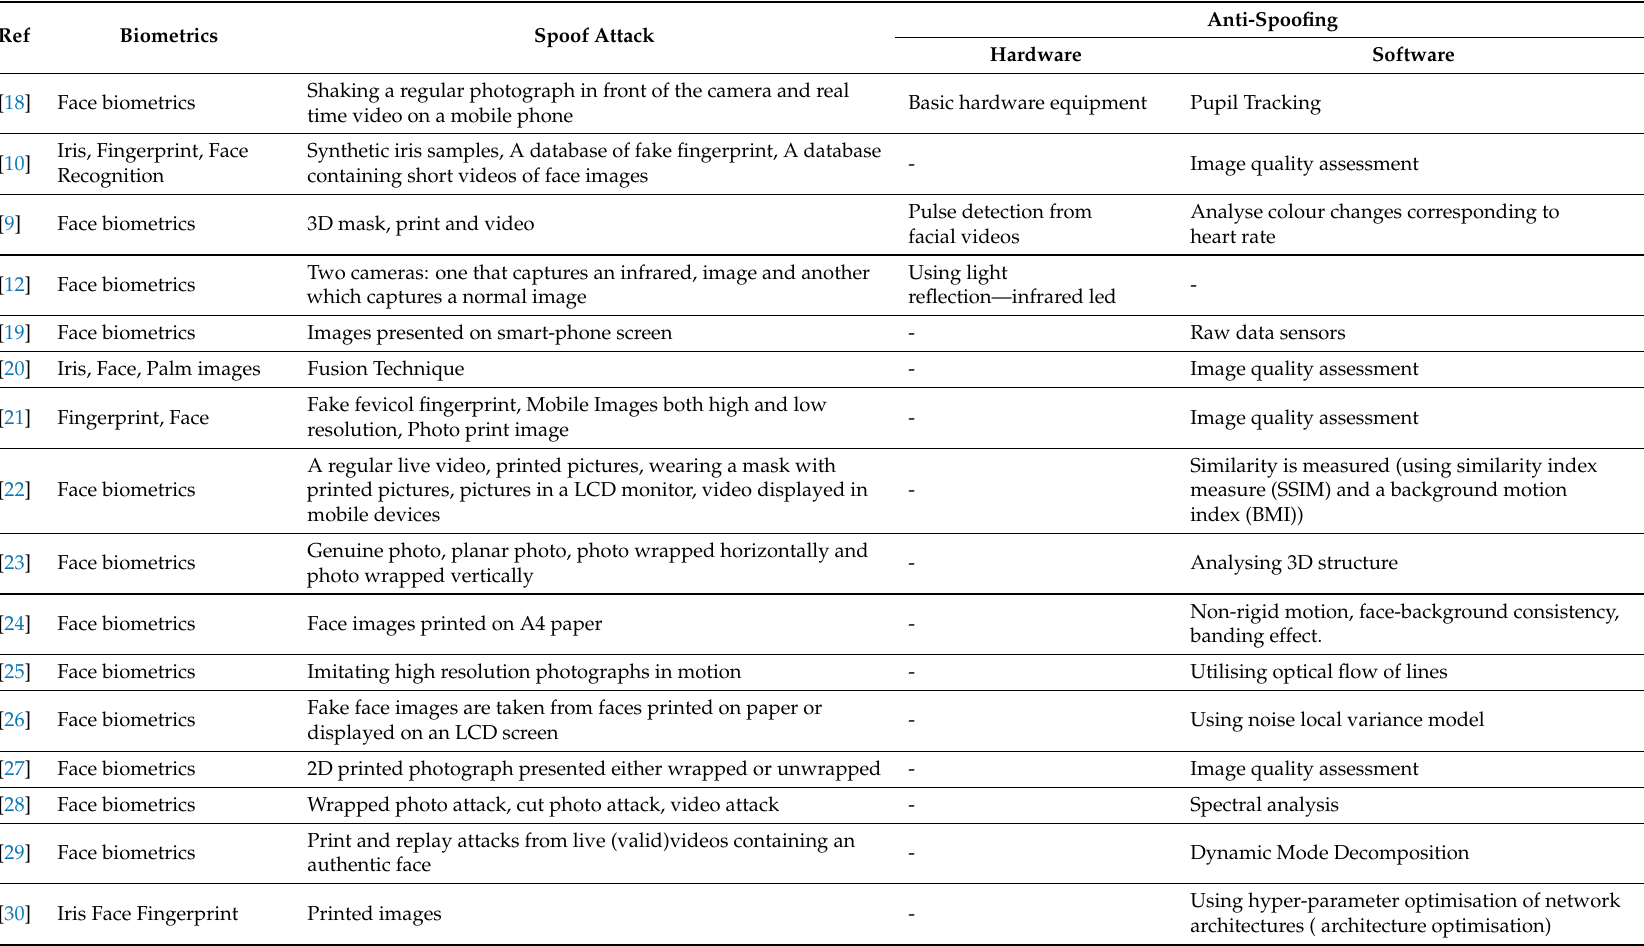
Table 2. Related work